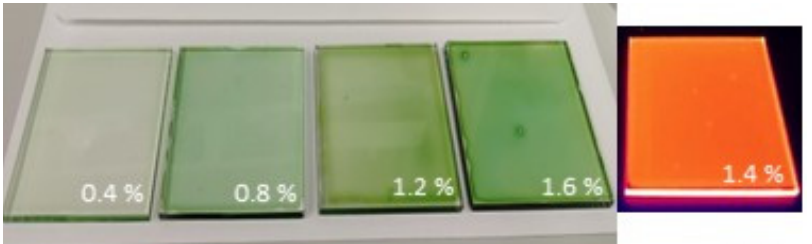
Figure 7. Examples of 50 × 50 × 3 mm 3 LSC devices containing compound 1c at different concentra- tions ( left ), as well as LR305 at 1.4 wt% ( right ).